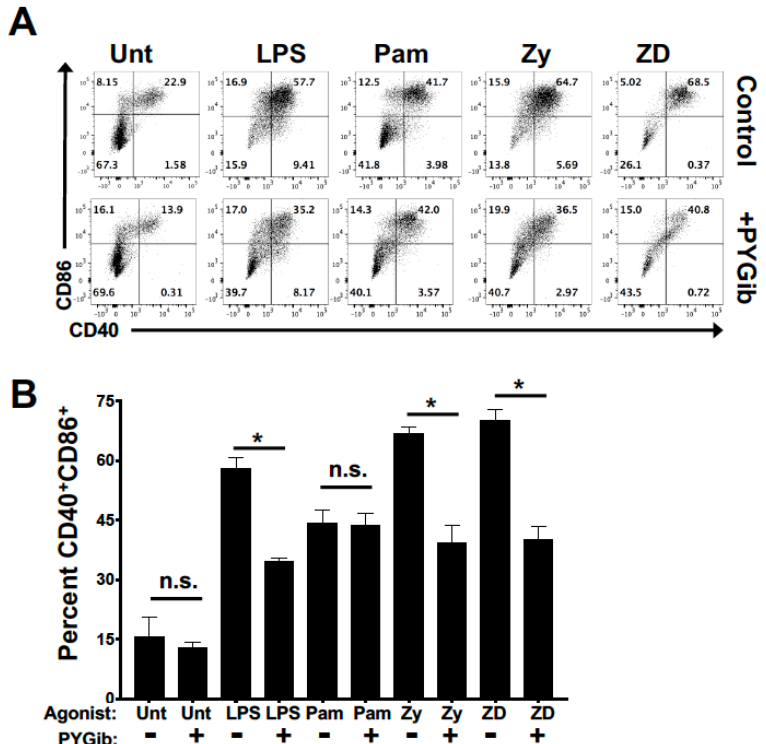
Figure 2. Glycogen metabolism supports DC maturation in response to both TLR and Syk-dependent CLR agonists: ( A ) DCs were stimulated for 18 h with the indicated ligands (LPS = lipopolysaccharide, Pam = Pam2CSK4, Zy = Zymosan, and ZD = Zymosan depleted) in the presence or absence of PYG inhibitor (PYGib) and then assessed by flow cytometry for maturation by CD86 and CD40 surface expression; ( B ) Percent of CD40 and CD86 double-positive cells for each condition as in ( A ). For all graphs, statistical values are represented with an asterisk (*) as significant when p values are equal to or below 0.05, with mean +/ − SD shown, n = 4.